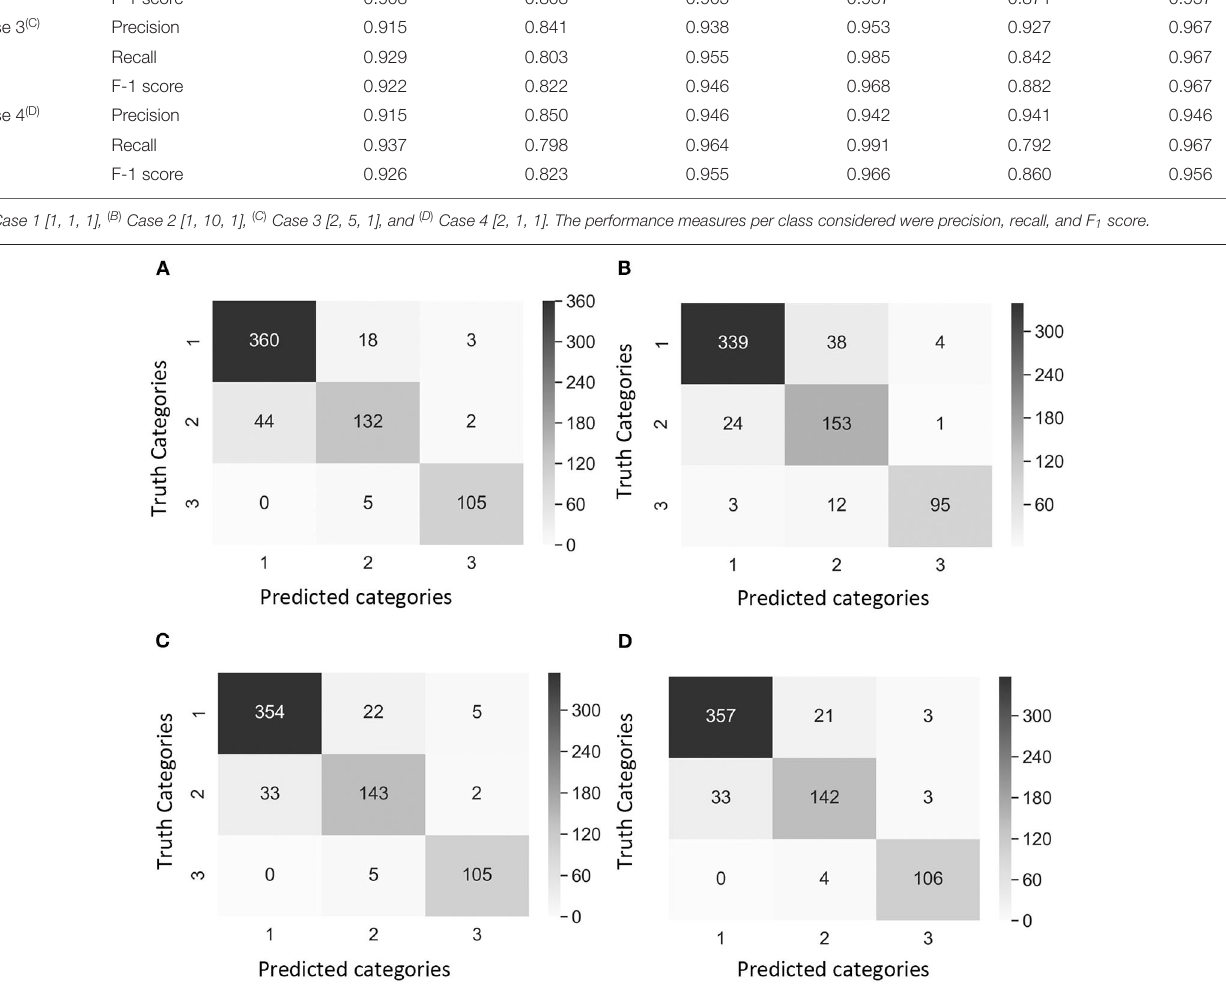
FIGURE 4 | Confusion matrix of the images of Dataset 1 (non-matured spikes only) showing “true” categories by Rater 1 (y-axis) and predicted categories by the CNN model (x-axis). Category 1: contained images with 0% severity, Category 2: 0.1–20% severity, Category 3: 20.1–100% severity. The cases of study presented different weights in the loss function [weight in Category 1, weight in Category 2, weight in Category 3]. (A) Case 1 [1, 1, 1], (B) Case 2 [1, 10, 1], (C) Case 3 [2, 5, 1], and (D) Case 4 [2, 1, 1]. Values and color intensity represent number of